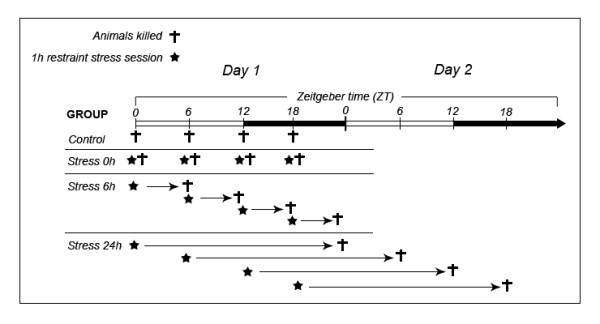
Experimental design.